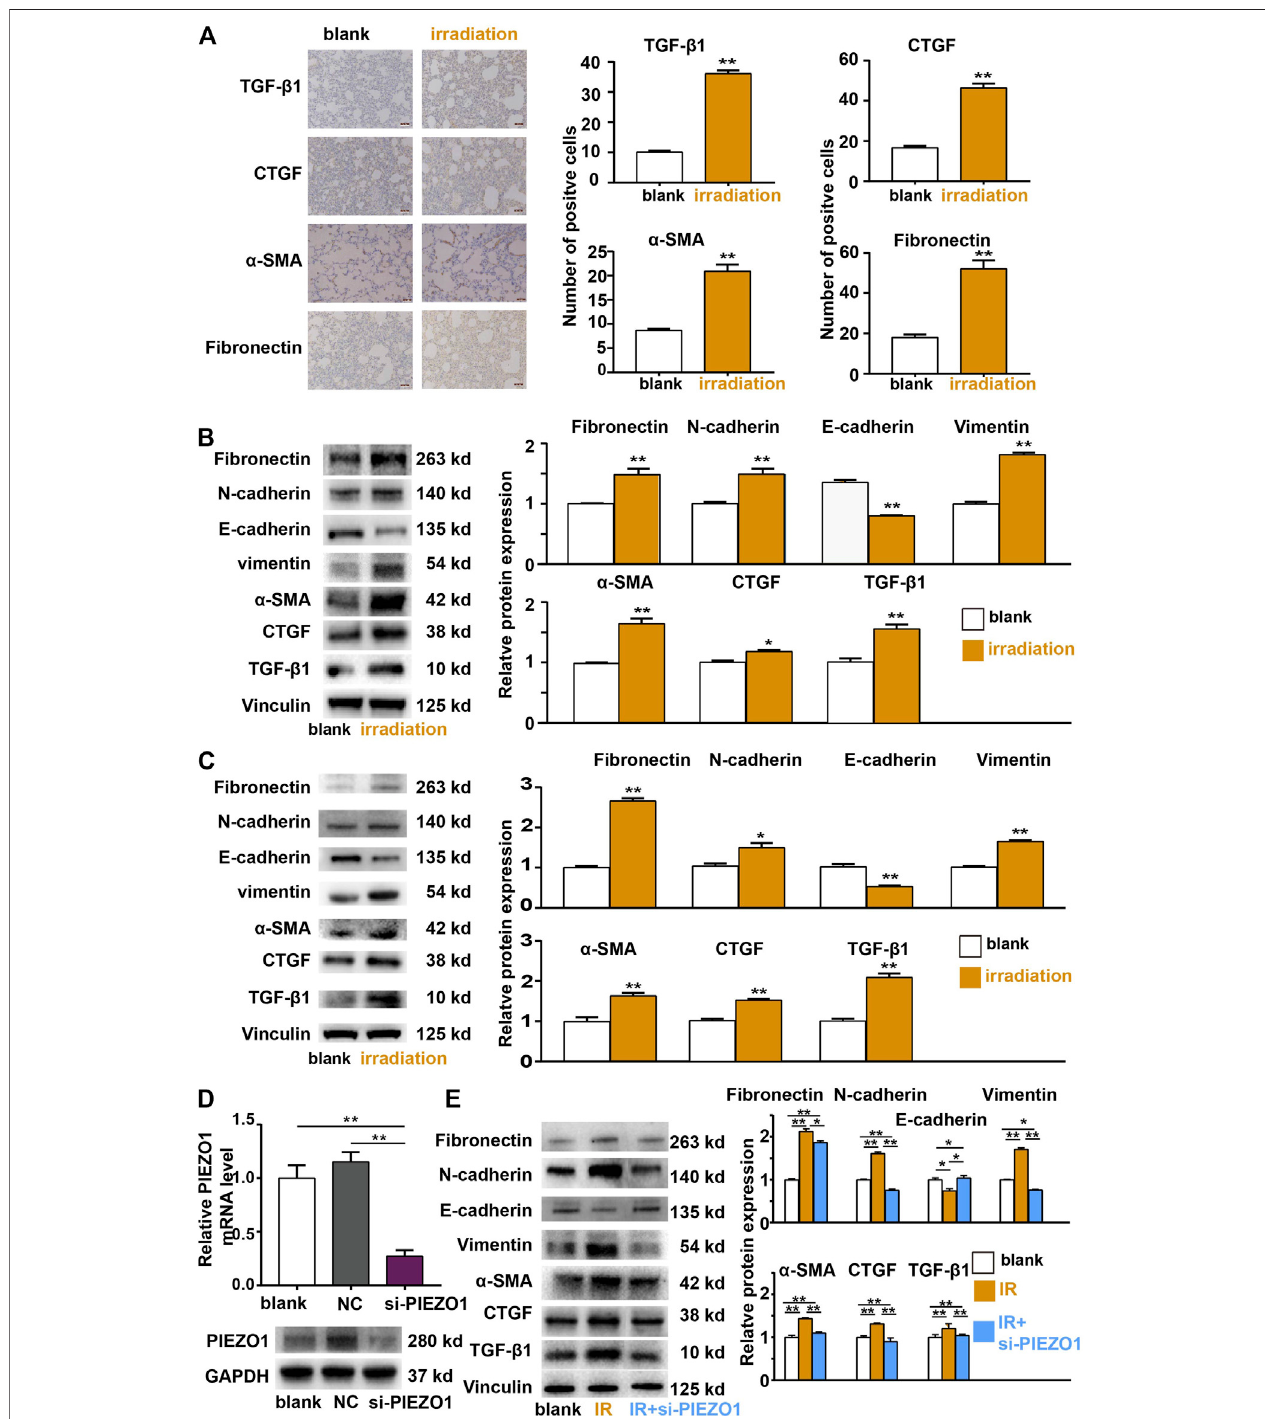
FIGURE 2 | Epithelial-mesenchymal transition (EMT) occurred after irradiation (IR) and is mediated by PIEZO1 signaling. (A) Immunohistochemical analyses found TGF- β 1, α -SMA,CTGF,andFibronectinexpressionwasincreased48 hafterIR. (B,C) Westernblottingresultsofratlungtissues (B) andRLE-6TN cells (C) showedthat the expression of EMT-related markers N-cadherin, Vimentin, TGF- β 1, α -SMA, CTGF, and Fibronectin were up-regulated and E-cadherin was down-regulated comparedtothoseofthecontrolgroup48 hafterIR. (D) PIEZO1mRNAandproteinexpressionweresuccessfulinhibitedbyspeci fi csiRNAtoPIEZO1(si-PIEZO1) compared with blank and negative control (NC). (E) Representative Western blotting images and histograms showing that IR-induced EMT-related protein expression changes could be partly reversed by PIEZO1 knockdown. Note: The Western blotting images have been subjected to cropping and stitching inresponse to the reviewers ’ comments. The original fi gures can be seen in the supplemental materials. Data are presented with the means ± SEMs (n (cid:2) 3). *, p < 0.05; and **, p < 0.01.